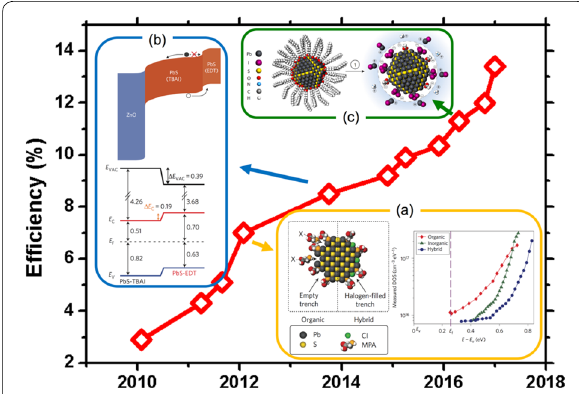
Fig. 4 NREL efficiency chart of CQD PVs. a Schematic of a CQD treated with an MPA ligand and a chloride (inorganic) ligand; density of states in the energy bandgap obtained from a transient photo- voltage measurement (reprinted with permission from ref. 21, Copy- right 2012 Macmillan Publishers Ltd.). b Band diagram of a CQD PV based on electron blocking with EDT-exchanged CQDs; energy band positions for various ligands obtained from ultraviolet photoelectron spectroscopy analysis (reprinted with permission from ref. 22, Copy- right 2014 Macmillan Publishers Ltd.). c Schematic of CQD and CQD ink (reprinted with permission from ref. 25, Copyright 2016 Macmillan Publishers